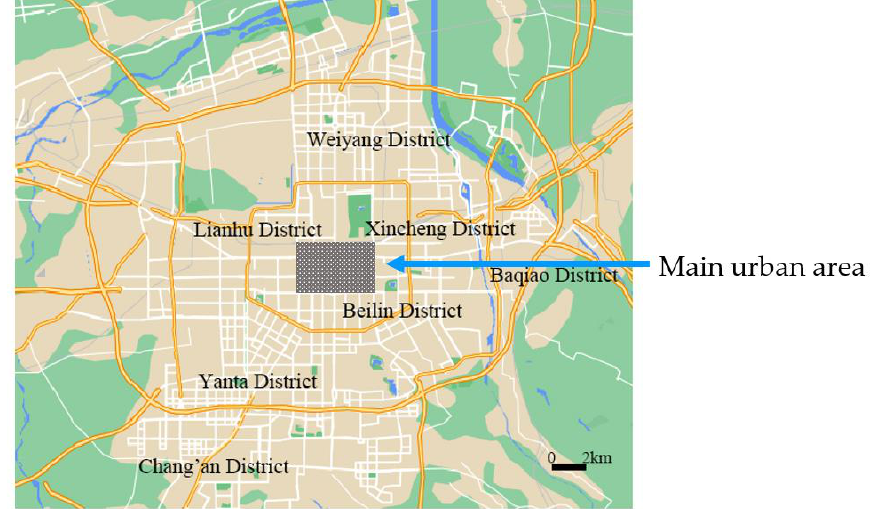
Figure 1. Research object Area of Xi ’ an ’ s main urban area (Google map, 2022).